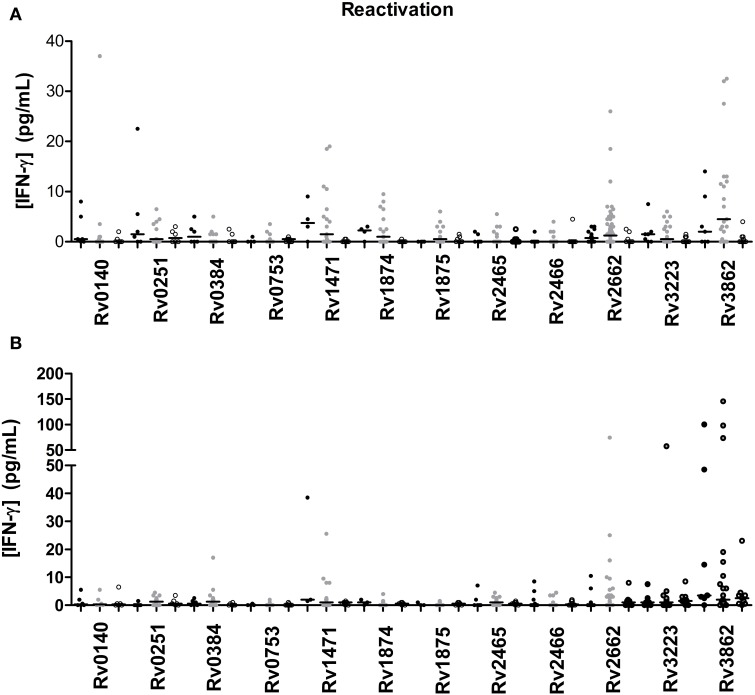
TB reactivation-associated antigen stimulated IFN-γ response (pg/ml) after short (A) or long-term (B) incubation of whole blood from individuals without LTBI (black dots), with LTBI (gray dots), and active TB patients (empty dots). The horizontal line represents the median.